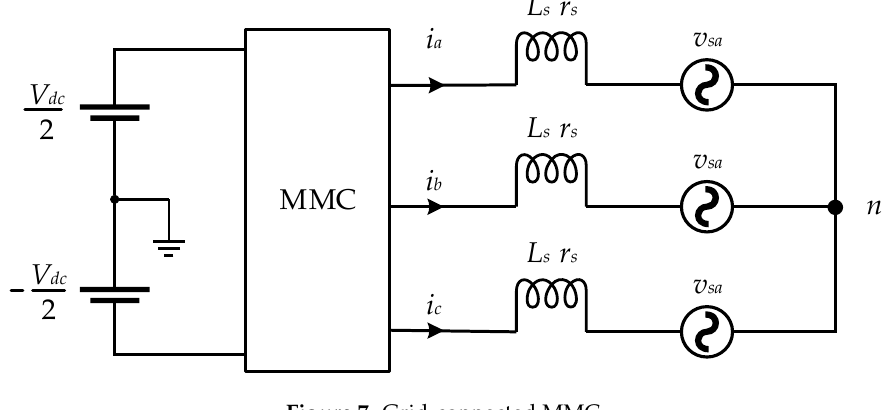
Figure 7. Grid-connected MMC.